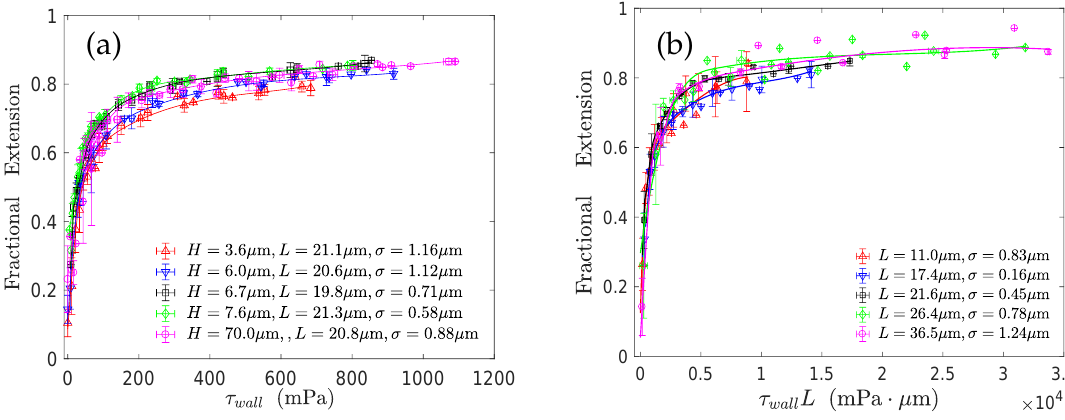
Figure 7. Experimental results obtained by Roy et al. [41] for the stretching of surface-tethered DNA molecules under weak confinement: ( a ) effect of the degree of confinement on the fractional extension and ( b ) validation of the unique functional relationship between the fractional extension and τ wall L